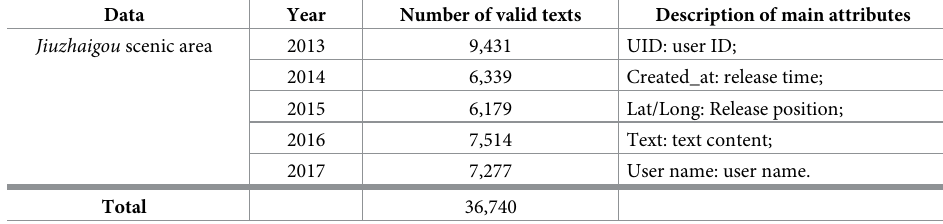
Table 1. Effective microblogs in Jiuzhaigou in